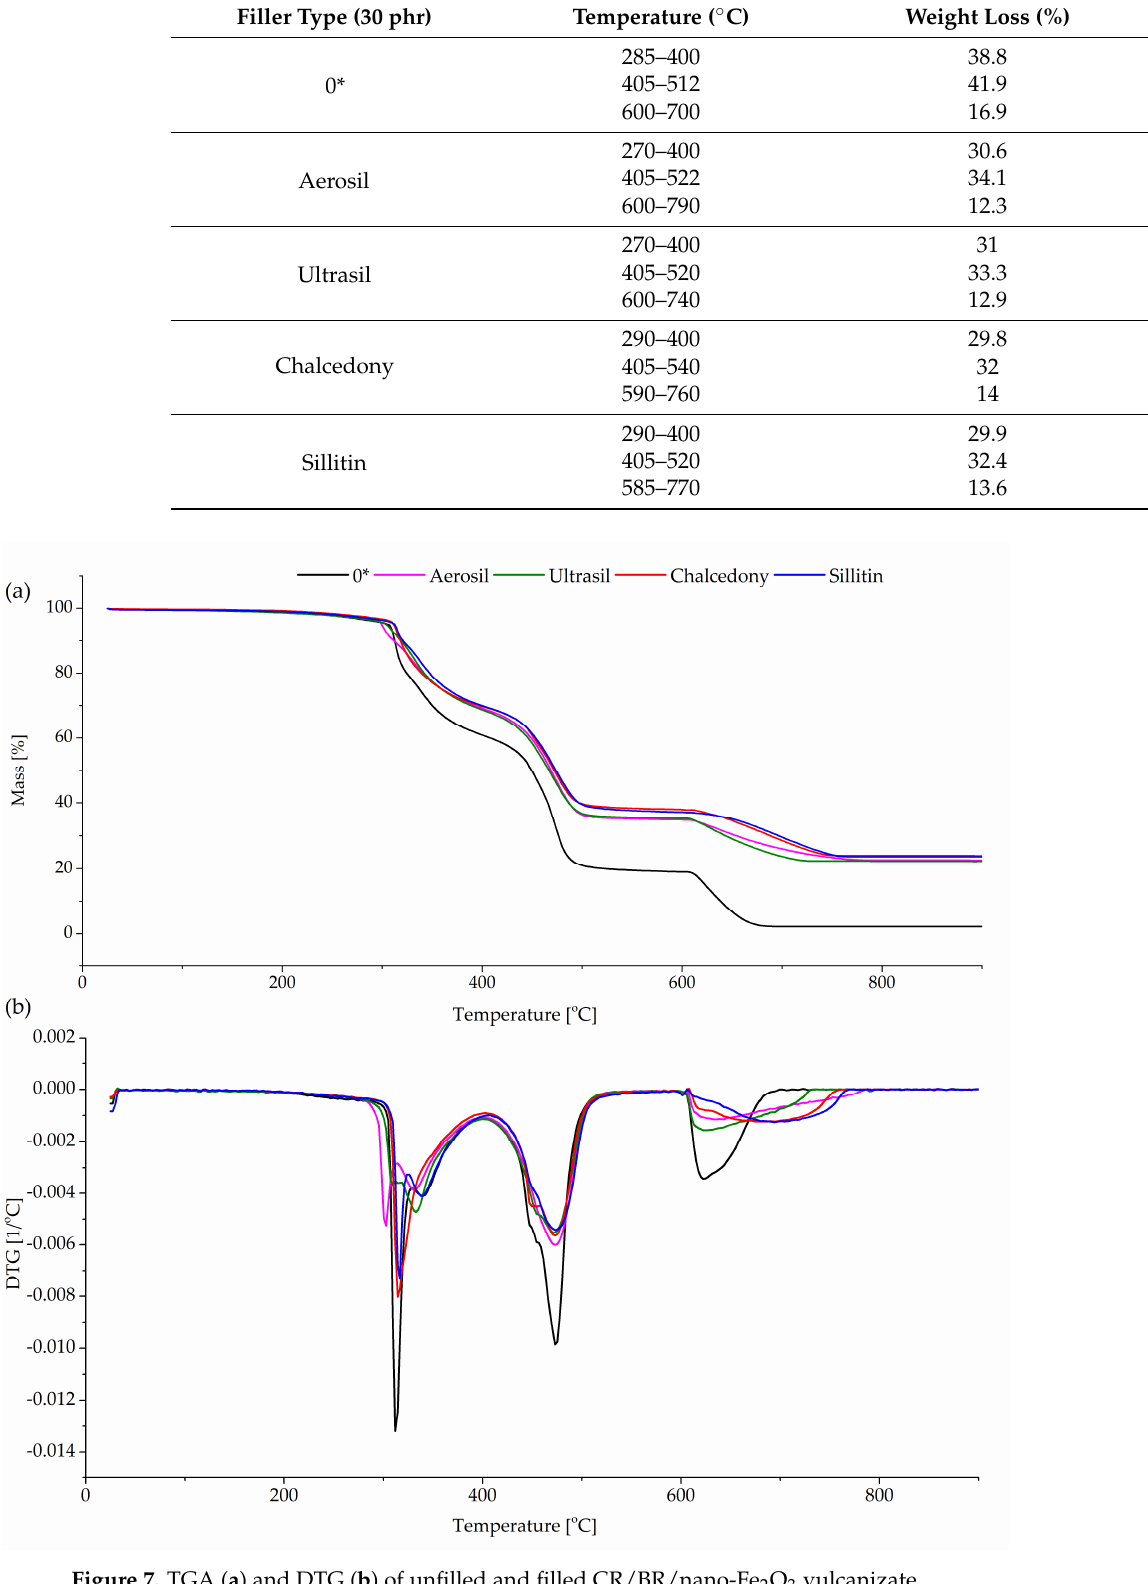
Figure 7. TGA ( a ) and DTG ( b ) of unfilled and filled CR/BR/nano-Fe 2 O 3